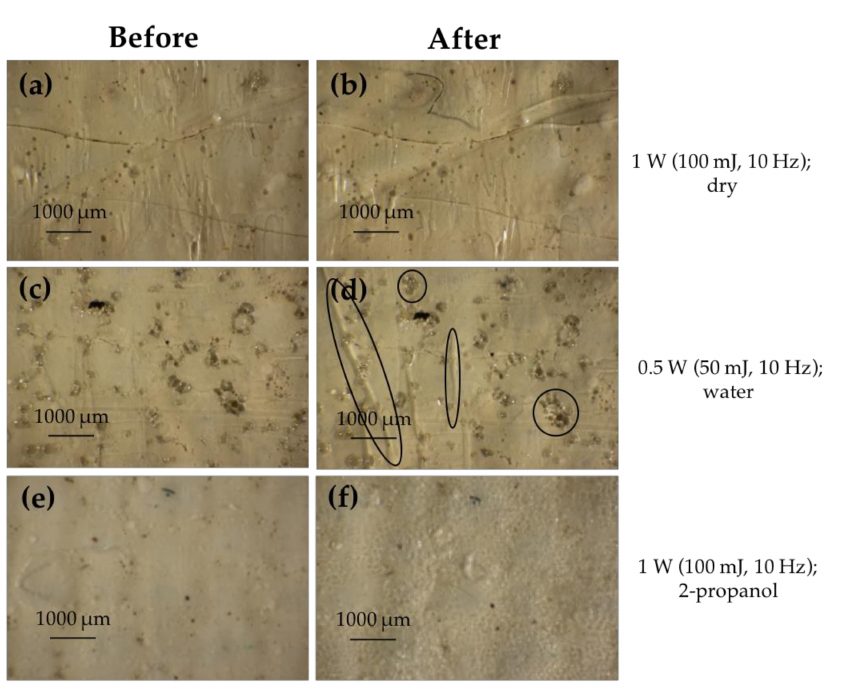
Figure 6. The microscopic images (32 × ) of P B67 removal by Er:YAG laser under varied conditions and parameters, conducted on lead white tempera mock-ups. ( a , c , e ) was taken before cleaning, while ( b , d , f ) was obtained after cleaning in dry and wet conditions with different laser power (1 W and 0.5